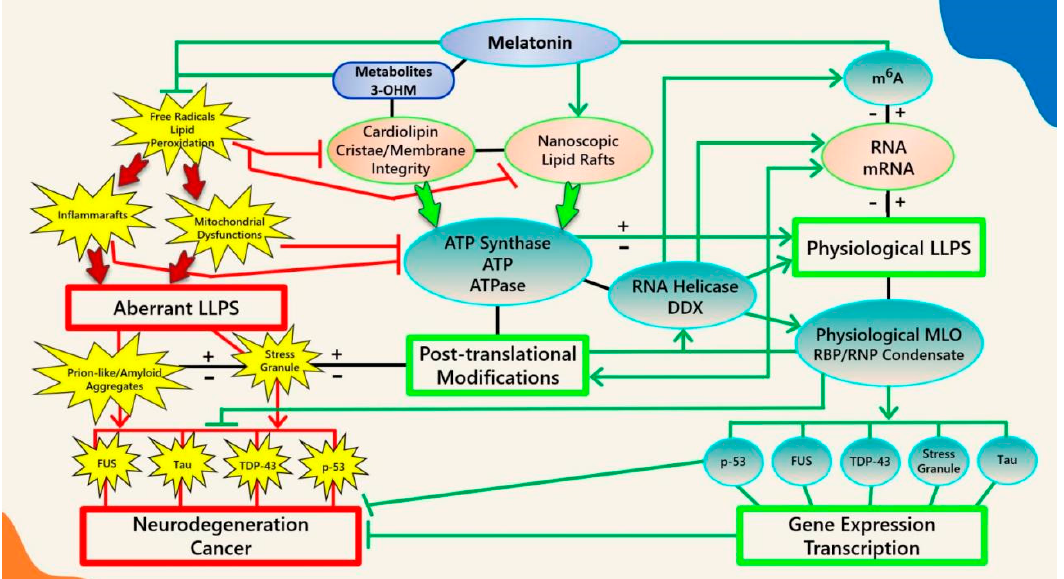
Figure 1. Schematic illustrating the regulation of biomolecular condensates by melatonin represented through observations reported in antioxidant protection against lipid peroxidation to maintain membrane/lipid raft composition/stability that serves to maintain adequate ATP levels in all cellular compartments to fuel, support, and regulate post-translational/m 6 A modifications that may fine-tune RNA dynamics in the assembly and disassembly of MLOs to prevent pathological aggregations in neurodegenerative disorders. LLPS: liquid–liquid phase separation; DDX: Dead-box RNA helicase; m6A: N 6 -methyladenosine; MLO: membraneless organelle; RBP: RNA-binding protein; RNP: ribonucleoprotein; PTM: post- translational modification (See Abbreviations for additional